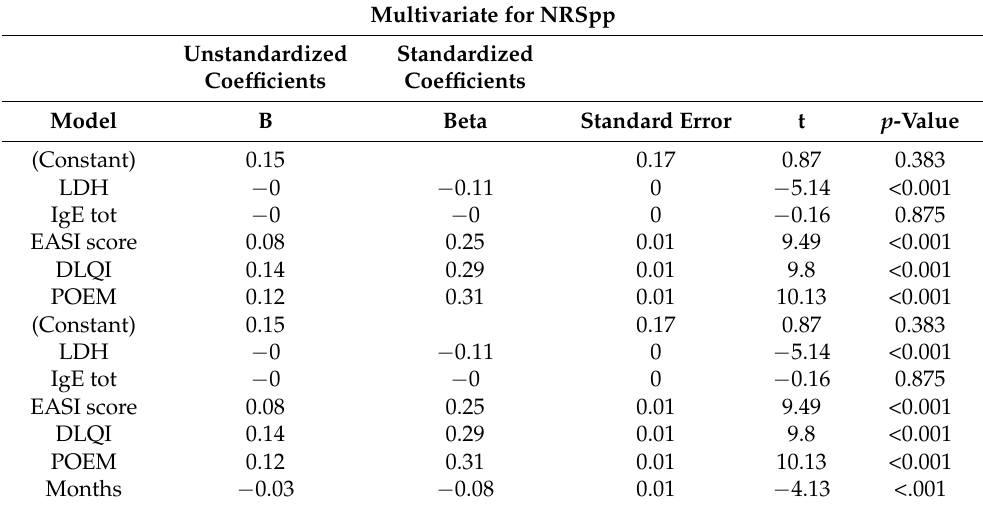
Table 4. Multivariate analysis for NRSpp with and without months of treatment.